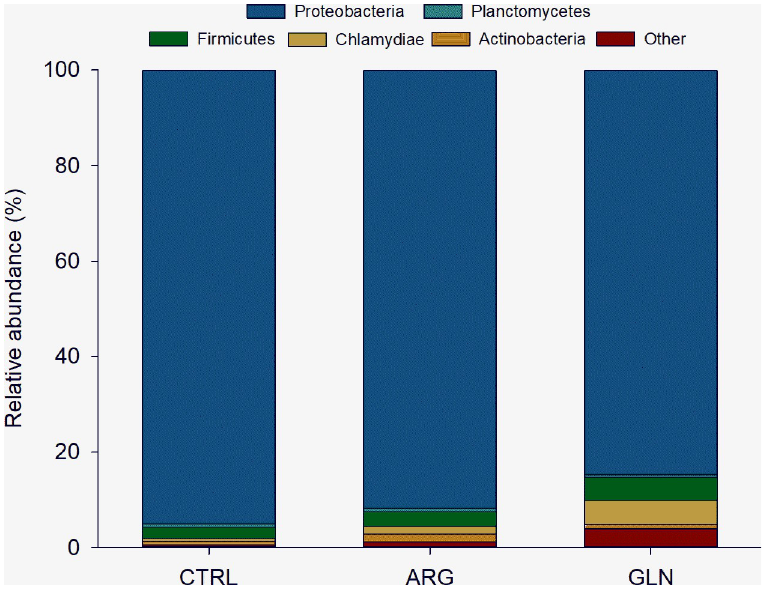
Fig 5. Composition of gut bacterial ecosystem at phylum level. Taxonomic composition of the average (%) phyla level of gut microbiota of zebrafish larvae (22 dpf) from control (CTRL), arginine (ARG) and glutamine (GLN) treatments. The plots represent the most abundant representatives’ phylum ( >